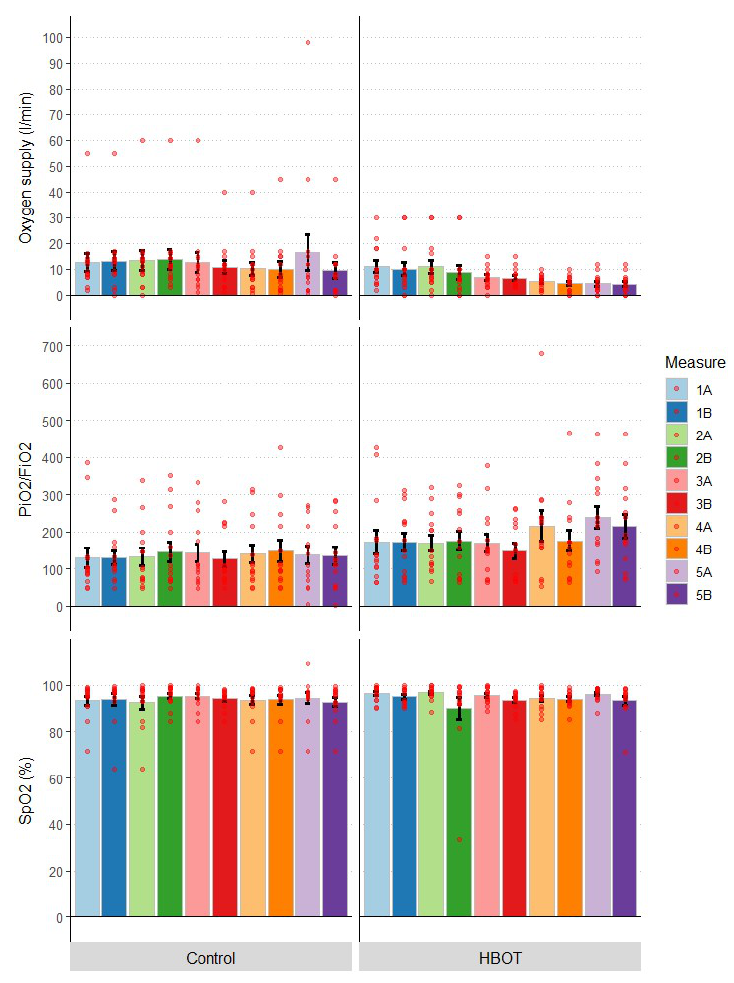
Figure 3. Change in blood gas levels and oxygen supply during the study by group; numbers indicate the day of measurement; A and B indicate measurement before or after the HBOT session on a given day, respectively; bars represent mean, error bars represent standard error, red dots indicate individual patient results; HBOT n = 14, Control n = 14.